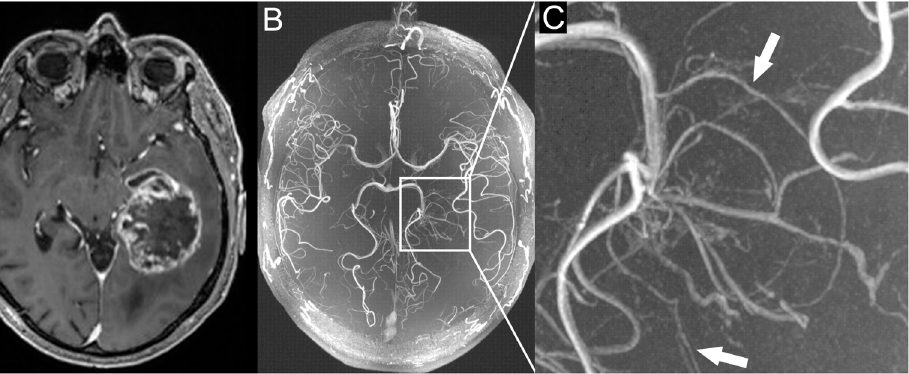
Figure 1. Patient with a left temporal glioblastoma. A) contrast enhanced T1-weighted images at 3 Tesla. B) 7 Tesla ToF angiography maximum intensity projection; enlarged in C). Tumor vessels with multiple branches can clearly be identified within the glioblastoma (white arrows in C). Signal intensity in the tumor vessels is reduced compared to the regular vessels due to signal loss in the irregular and leaky tumor